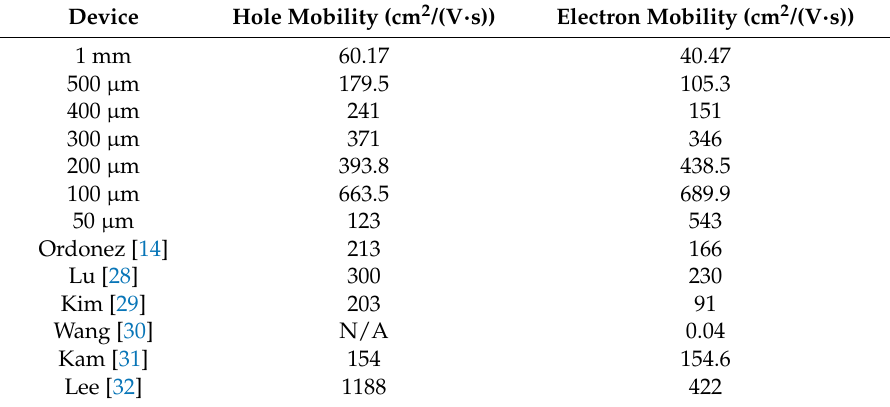
Table 1. This table details the electron and hole mobility of each channel length device and is compared to those in other